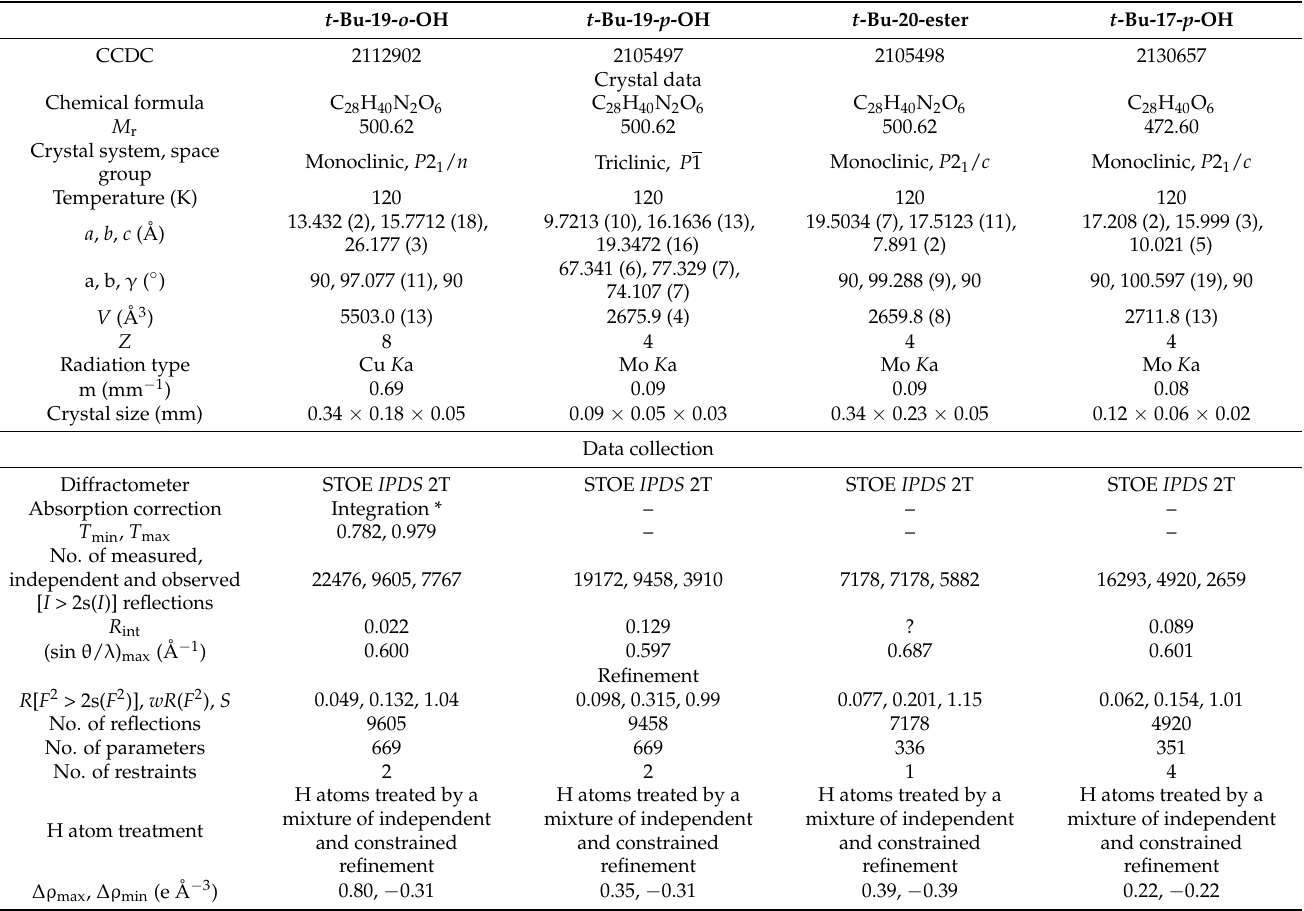
Table 4. Crystal data and structure refinement details for t -Bu-19- o -OH , t -Bu-19- p -OH , t -Bu-20-ester and t -Bu-17- p -OH